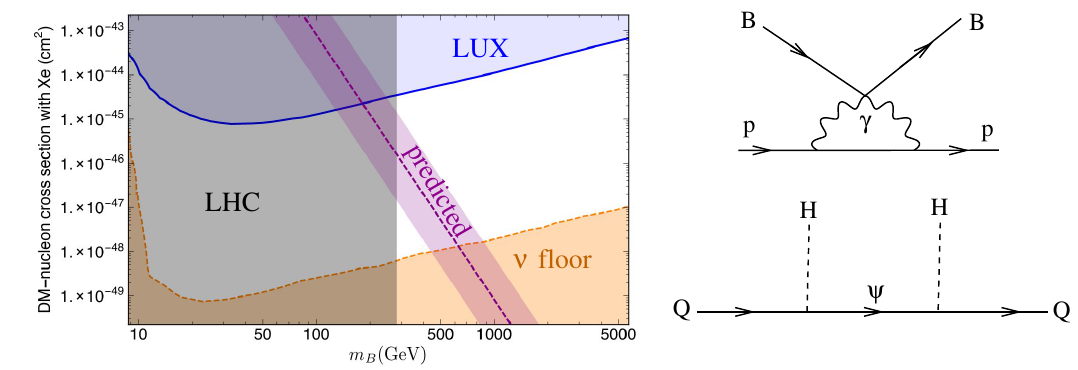
Figure 27: Left: constraints on stealth DM (spin 0 baryon) scattering on protons induced by electric polarizability, adapted from Ref. [ 147 ] . Upper right: dark baryon- proton scattering induced by electric polarizability operator of Eq. (55). Lower right: diagram leading to effective Higgs portal coupling to a hyperquark Q that is a triplet under SU(2) EW